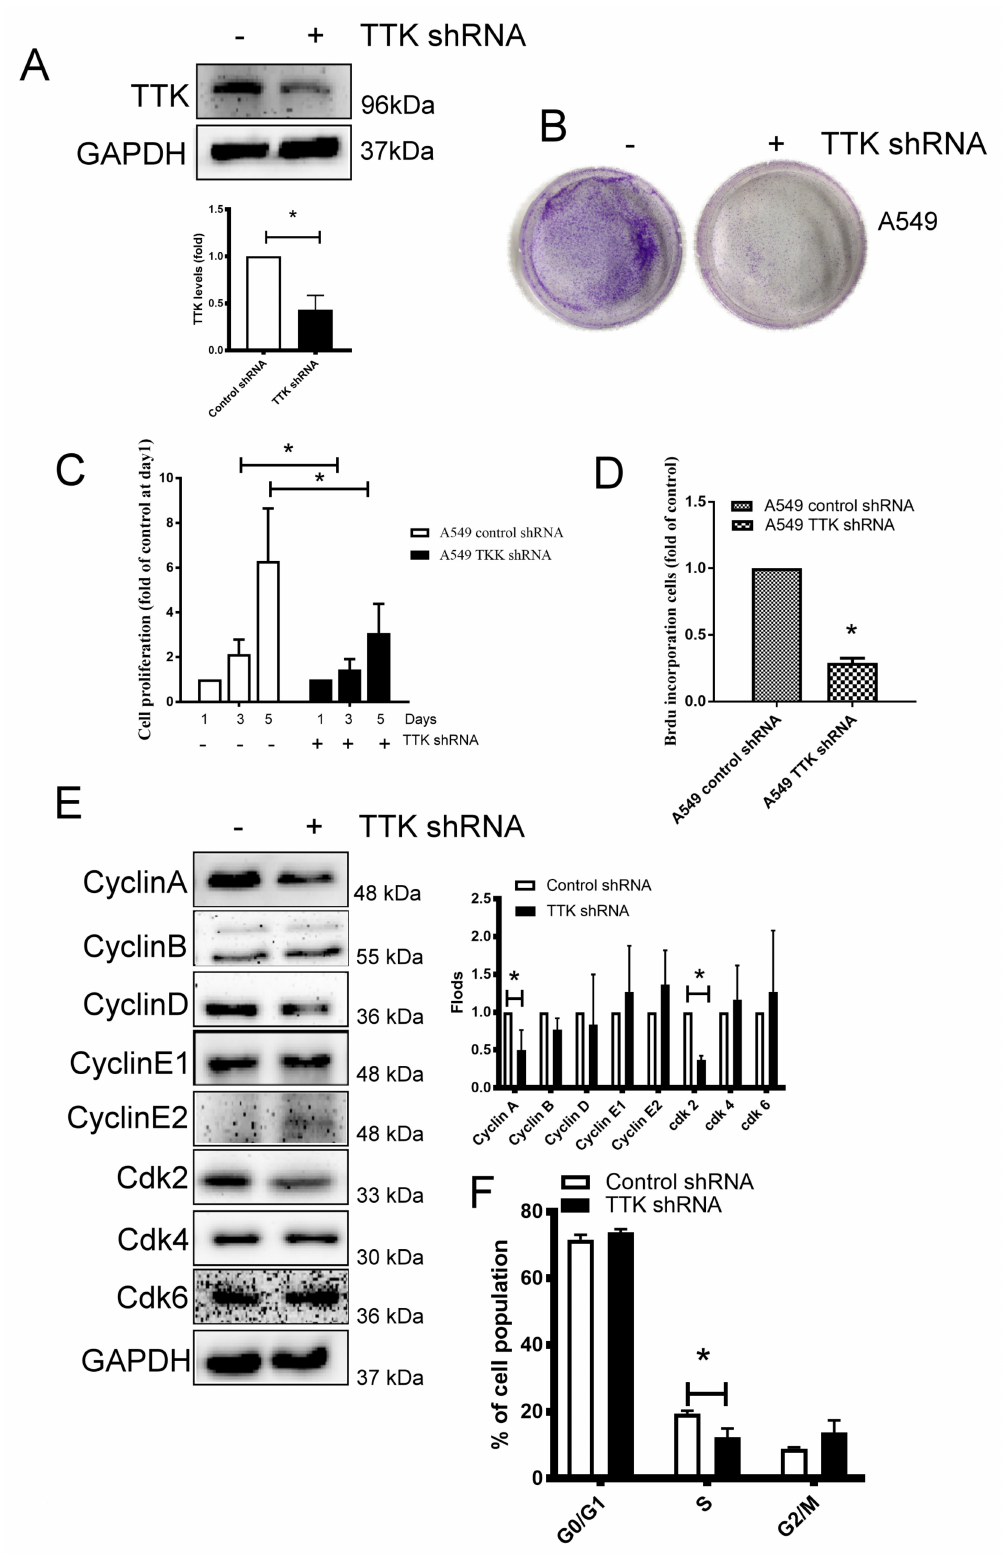
Figure 2. Knockdown of TTK inhibits cancer proliferation. ( A ) The e ffi cacy of TTK knockdown in A549 cells. A549 cells were transfected with control or TTK shRNA plasmid, and the stable clones were established by puromycin selection. The expression of TTK was determined by an Immunoblot. Inhibition of TTK decreased cell proliferation, as determined by colony formation ( B ), WST-1 ( C )